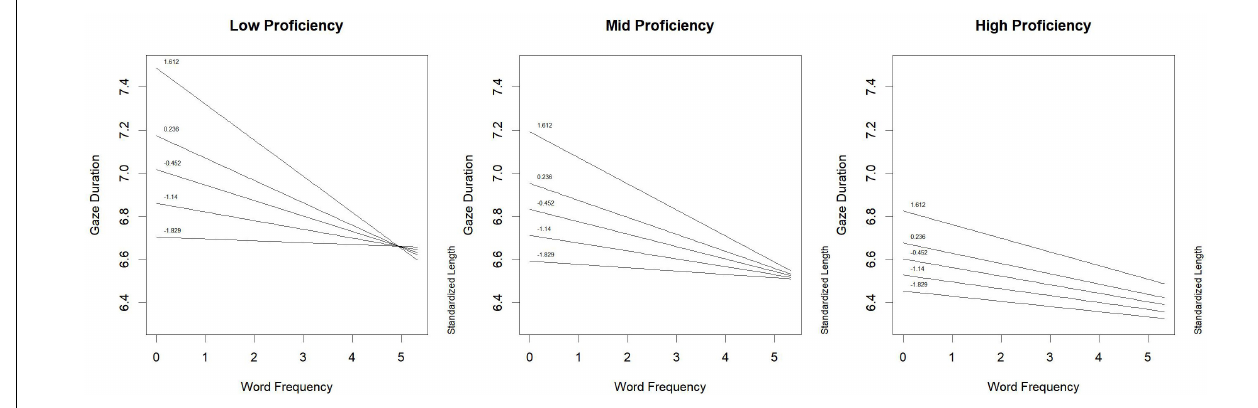
FIGURE 1 | Words derived from noun base: effect of proficiency by word frequency by word length interaction on gaze duration.